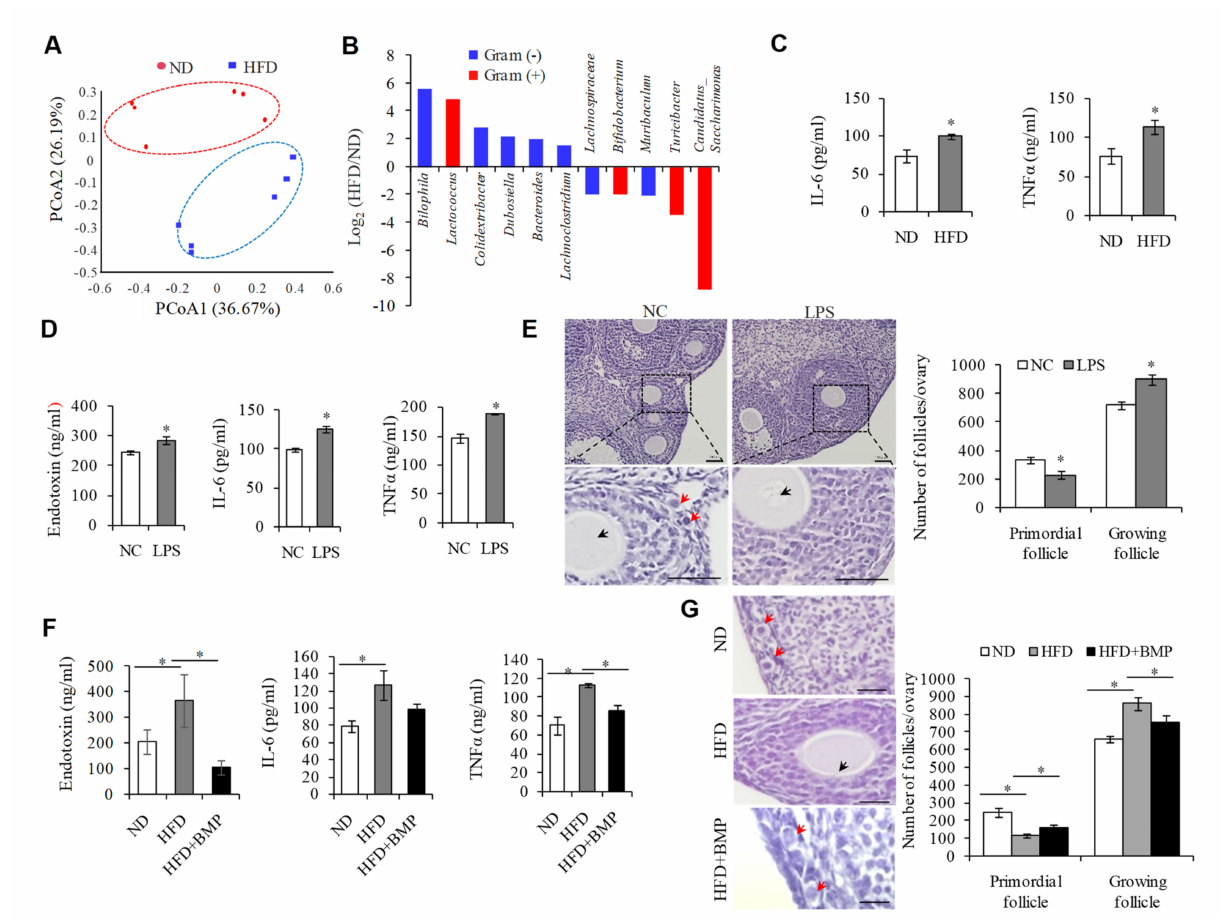
Figure 1. Endotoxemia due to imbalance of intestinal microflora in HFD mice contributes to the overactivation of primordial follicles. ( A ) Principal coordinate analysis (PCoA) graph based on the operational taxonomic unit (OTU) matrix of ND and HFD fecal microbiota ( n = 6). ( B ) Log2 ratio of up- and down-regulated bacteria at the genus level between HFD and ND groups. ( C ) ELISIA detecting serum IL-6 and TNF α levels in ND ( n = 3) and HFD ( n = 3) mice. ( D ) ELISIA assay detecting serum concentrations of endotoxin ( n = 5), IL-6 ( n = 3) and TNF α ( n = 3) protein levels in NC and LPS-treated groups. ( E ) Representative H&E staining images and follicle number counts showing that the primordial follicle pool in LPS-treated mice was significantly decreased compared to NC mice. n = 10. Scale bar = 100 µ m. ( F ) ELISIA assay detecting serum concentrations of endotoxin, IL-6, and TNF α in ND ( n = 3), HFD ( n = 3), and HFD+BMP ( n = 3) groups. ( G ) Representative H&E staining images and follicle number counts showing that blocking endotoxin with BMP could reduce the overactivation of primordial follicles when exposed HFD ( n = 5). Red arrows represent primordial follicles. Black arrows represent growing follicles. Scale bar = 50 µ m. * p <